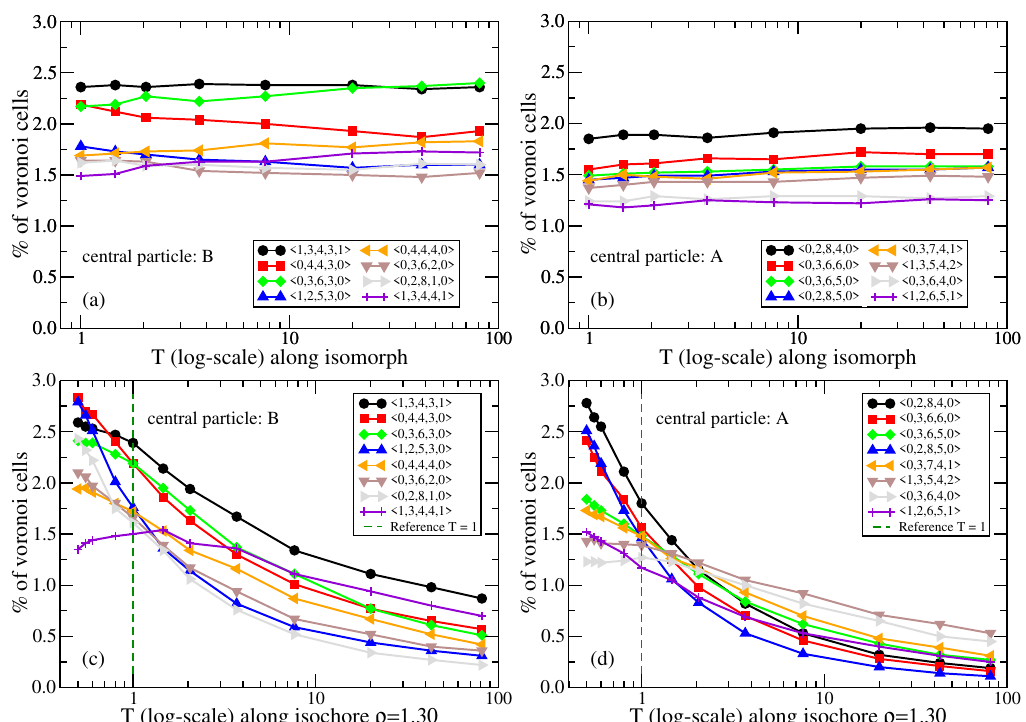
Figure 12. Temperature dependence of the occurrence of eight of the most abundant Voronoi structures at the reference state point ( ρ , T ) = ( 1.30,1.00 ) , plotted for the NiY 2 binary mixture as follows: along the isomorph as a function of the logarithm of the temperature ( a , b ), along the ρ = 1.3 isochore as a function of the logarithm of the temperature ( c , d ). In ( a , c ) the central particle is of type B, in ( b , d ) it is an A particle. The Voronoi structures are isomorph invariant to a good approximation, but vary significantly along the